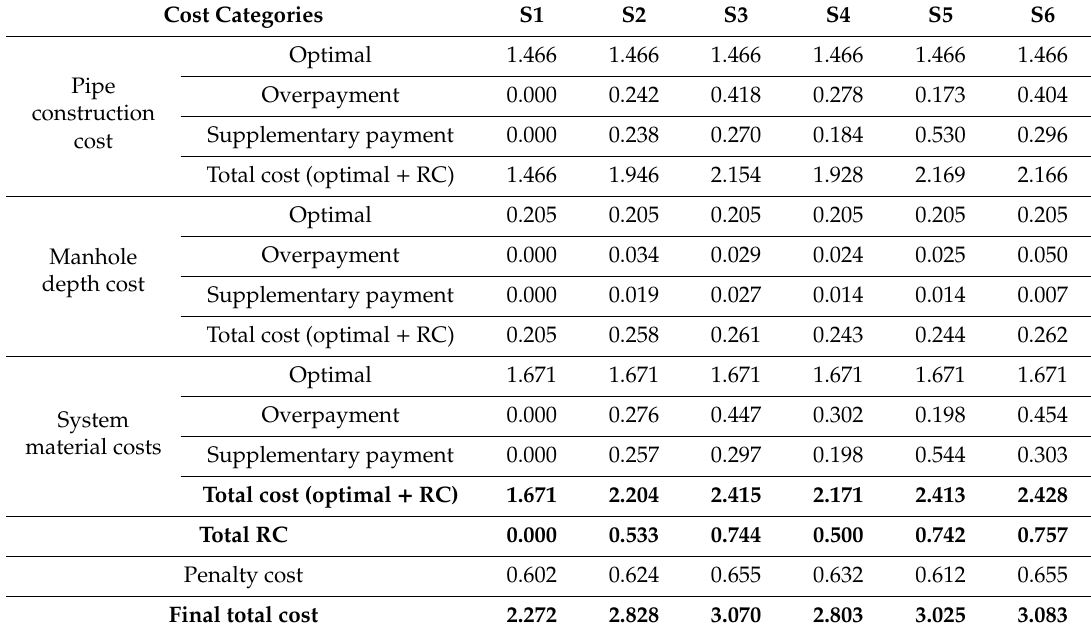
Table 2. Cost analysis of D1 determined in Phase I under various alternative scenarios.